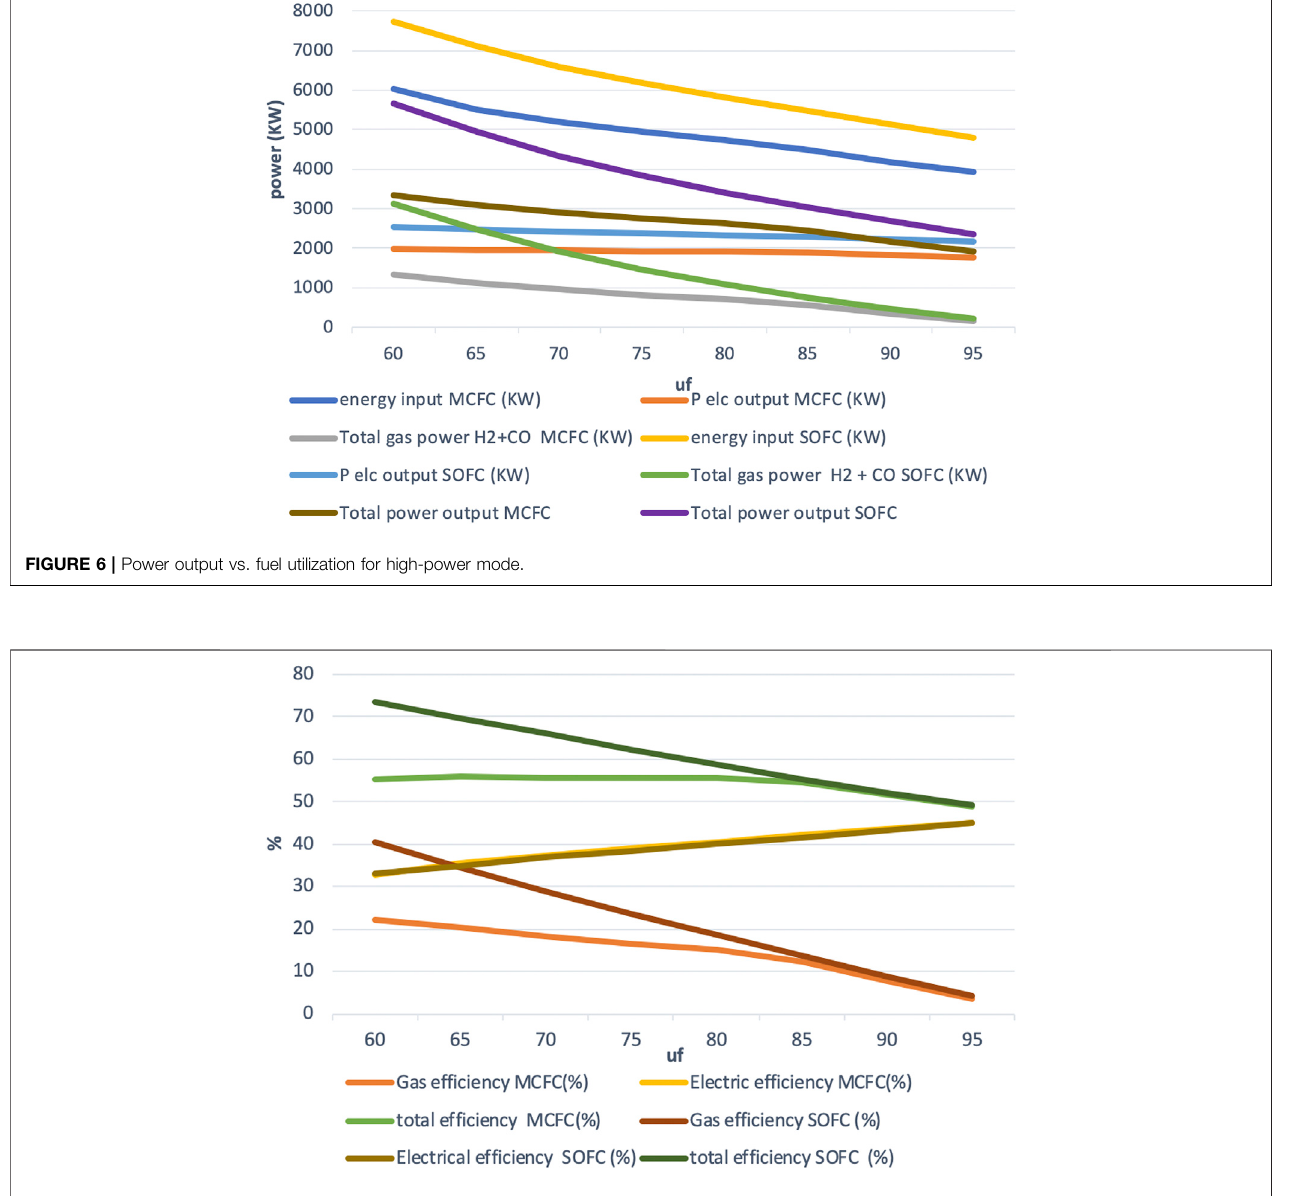
FIGURE 7 | Ef fi ciency vs. fuel utilization for high-power